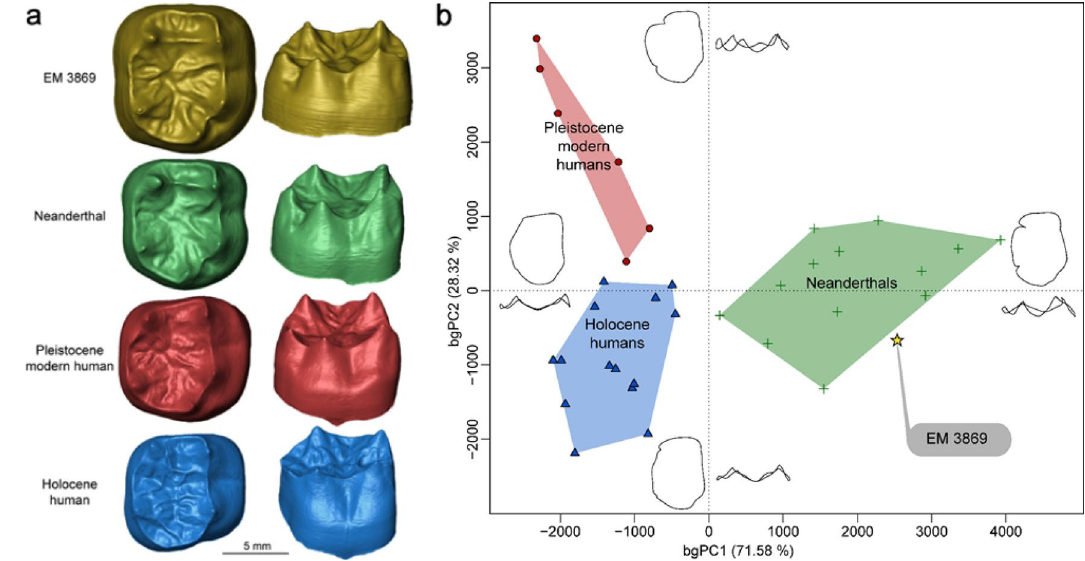
Figure 3. Virtual rendering of and Geometric morphometric analyses of the enamel-dentine junction (EDJ) shape of EM 3869. ( a ) Enamel-dentine junction (EDJ) of EM 3869 compared with those of Neanderthal, Pleistocene and Holocene modern human individuals. The specimens are oriented in occlusal (left) and buccal views (right). ( b ) Between group principal component analysis of the 3D semilandmark Procrustes-registered shape coordinates of the EDJ. The wireframes at the end of the axes illustrate the extreme morphological variation trends in occlusal (mesial aspect upward and buccal on the right) and buccal views (mesial aspect